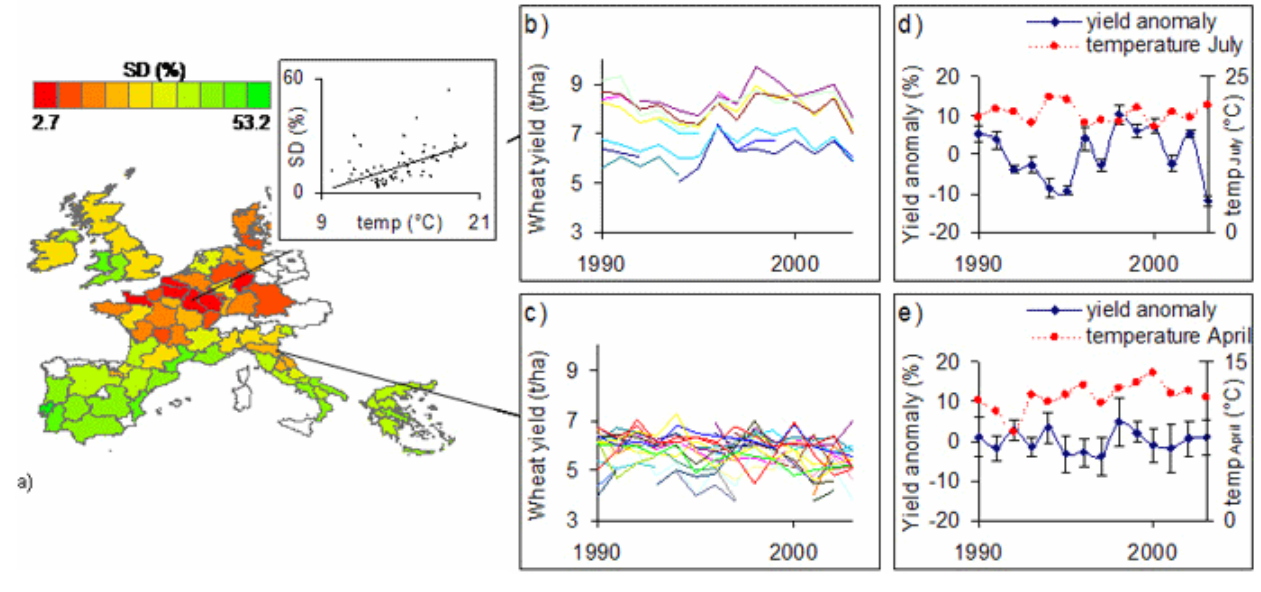
Fig. 6. (a) Spatial distribution of the variation in farm type yield variability (SD, %), and relationships to average temperature (temp, °C) from 1990–2003. Wheat yield variability is similar for different farm types in (b) Champagne-Ardenne, whereas in (c) Emilia-Romagna the diversity in wheat yield variability is larger. In (d) Champagne-Ardenne, standard deviations in the relative wheat yield anomaly for individual years are small (SD = 3.7) and regional yield anomalies (from the trend) are significantly different from zero and correlated to temperature, ( r = -0.66 with temp , r = -0.44 with temp). July However, in (e) Emilia-Romagna, the standard deviations are large (SD = 8.3) and regional yield anomalies are not significantly different from zero and are not significantly correlated to temperature ( r = -0.13 with temp , r = 0.33 with temp). Note, temperatures shown in (d) and (e) refer to the months April with the largest negative